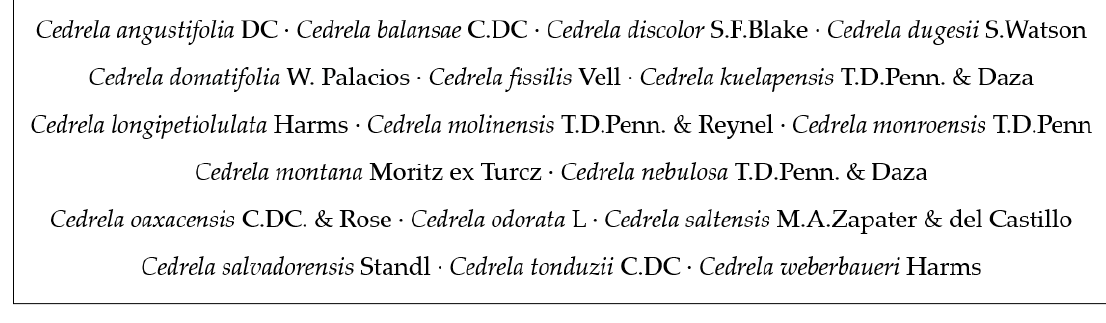
Figure 1. Accepted names of 18 Cedrela species. Data from The Plant List site (http://www.theplantlist.org/tpl1.1/search?q=cedrela) and Palacios et al. [3].